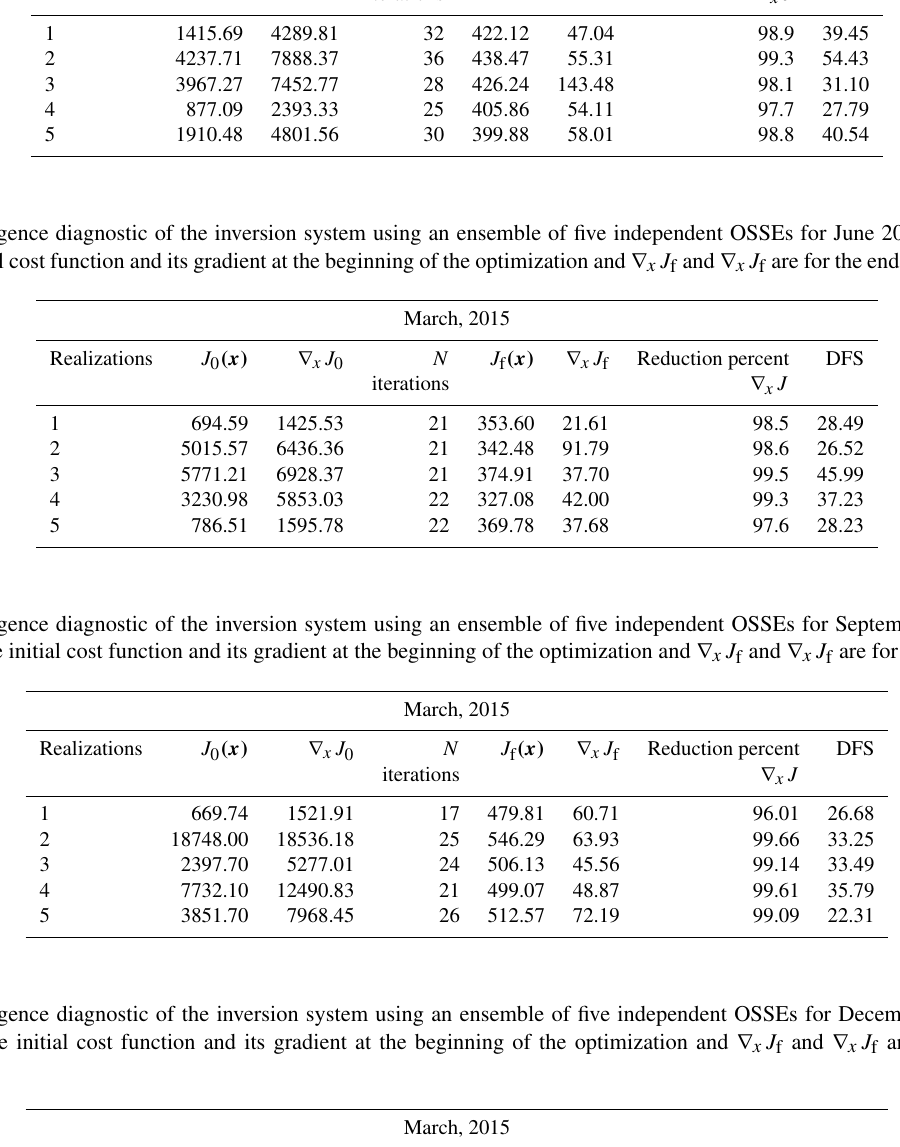
Table A4. Convergence diagnostic of the inversion system using an ensemble of five independent OSSEs for December 2015 ( ∇ x J 0 and ∇ x J 0 represent the initial cost function and its gradient at the beginning of the optimization and